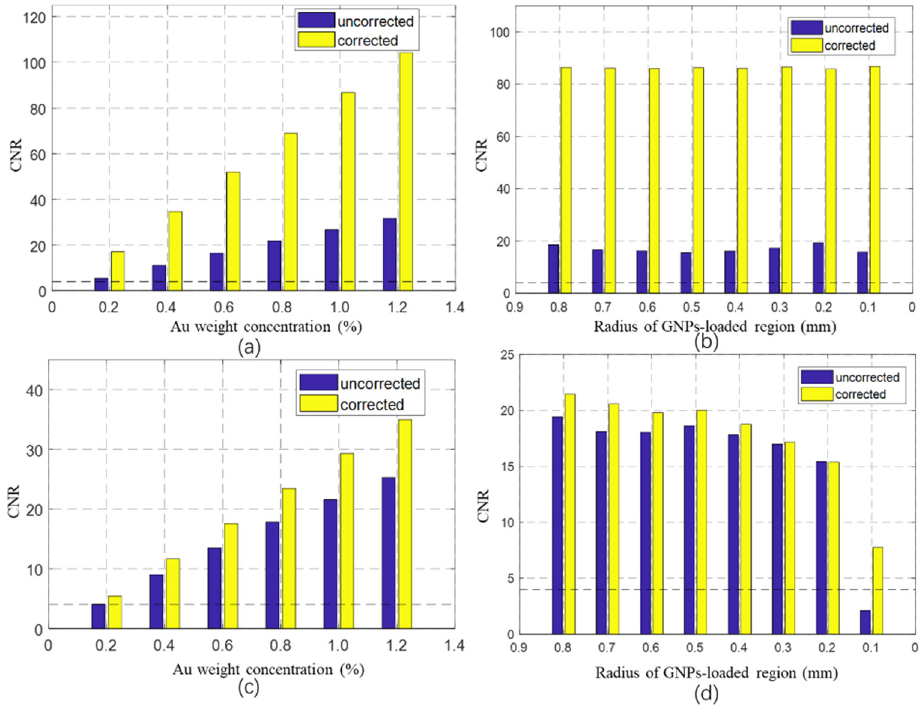
Figure 12. Contrast to noise ratio (CNR). ( a , b ) acquired through numerical simulation, ( c , d ) acquired through Monte Carlo simulation.